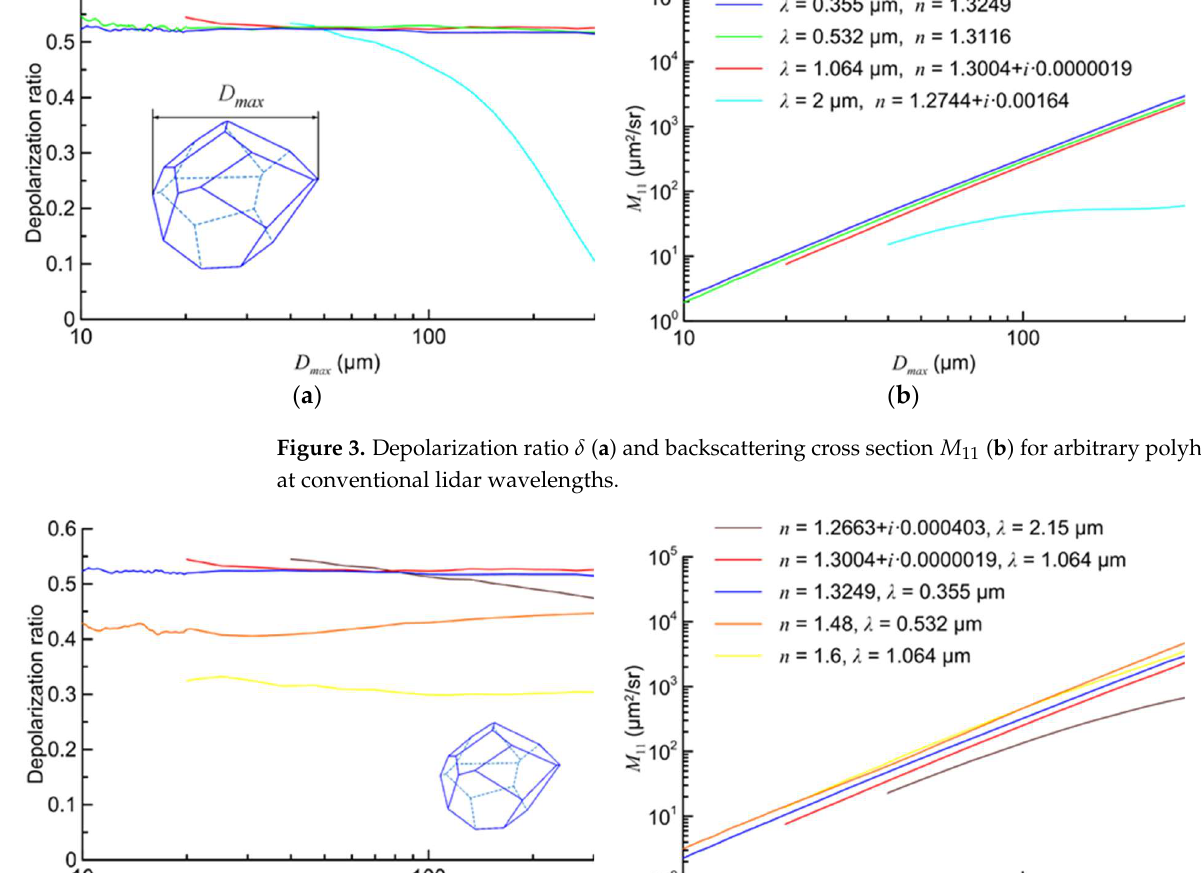
Figure 4. Depolarization ratio δ ( a ) and backscattering cross section dron at the artificial magnitudes of the refractive index.